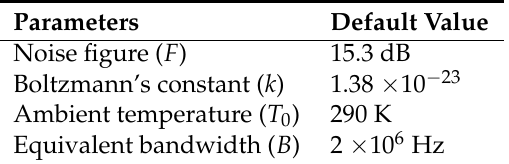
Table 3. CC2420 noise floor parameters